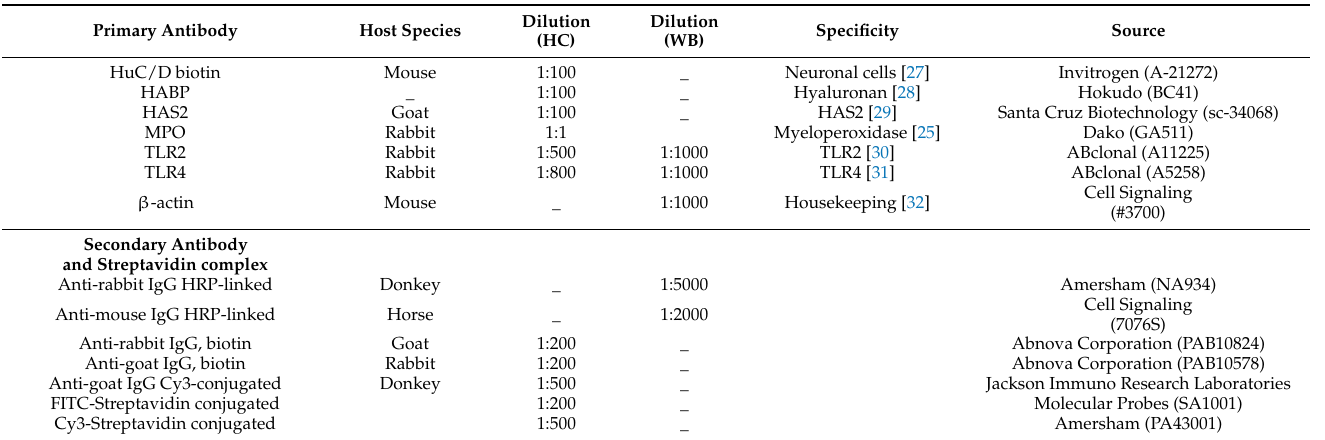
Table 1. List of primary and secondary